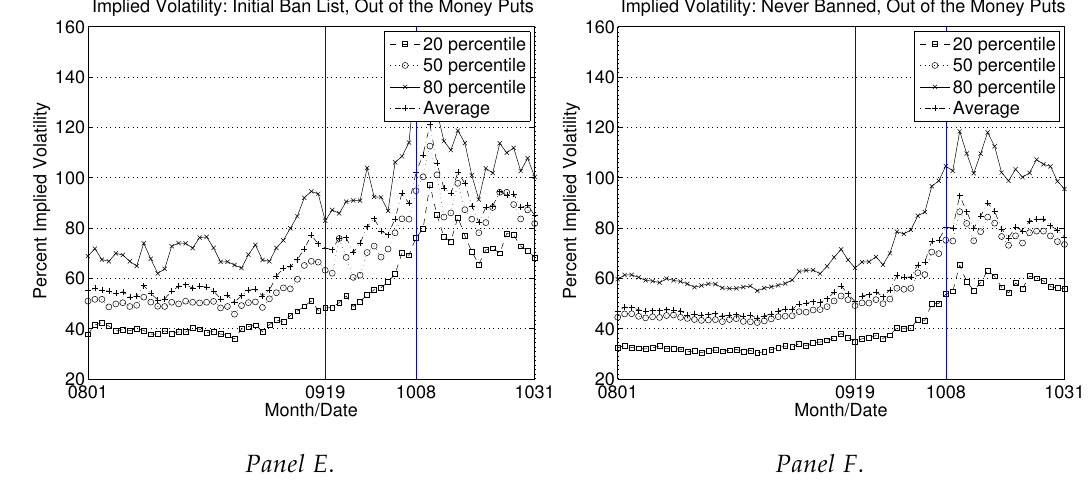
Figure 6. Time series of cross sectional options summary statistics: Out of the money put options of Initial Ban List and Never Banned Stocks during the ban and non-ban periods: ( A , C , E ) results for the three variables for Initial Ban List Stocks; and ( B , D , F ) results for the three variables for Never Banned